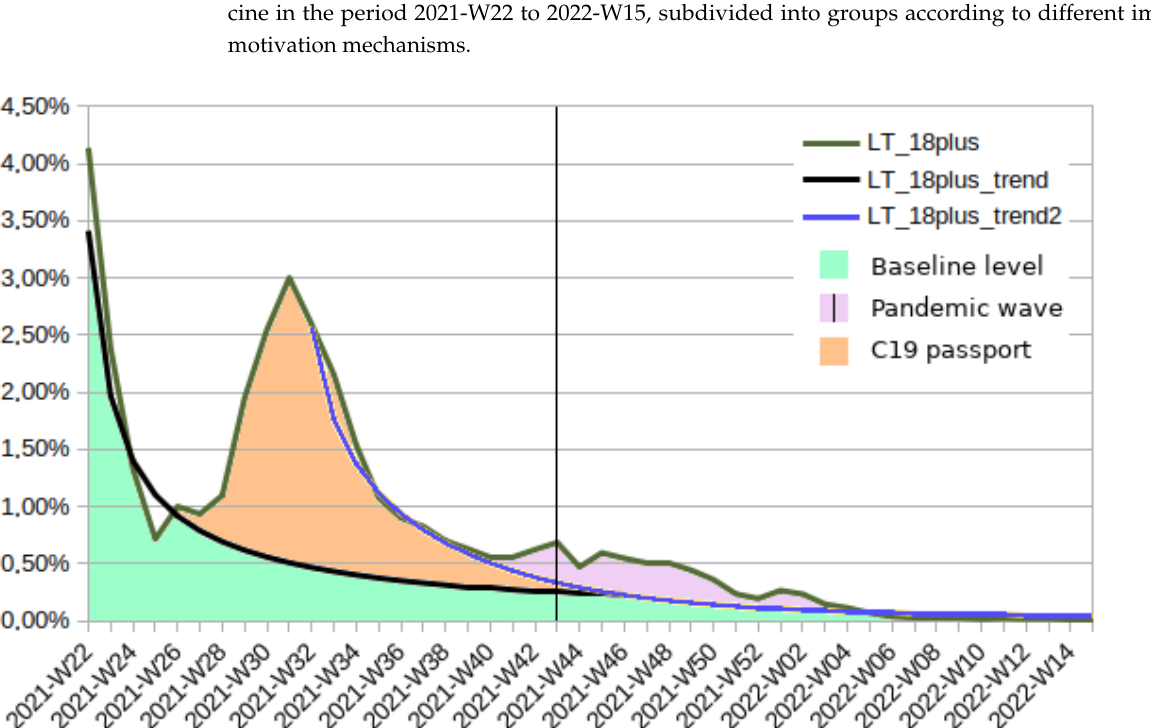
Figure 3. Percentage of Lithuanian adult population that received the first dose of the COVID-19 vaccine in the period 2021-W22 to 2022-W15, subdivided into groups according to different implied motivation mechanisms.